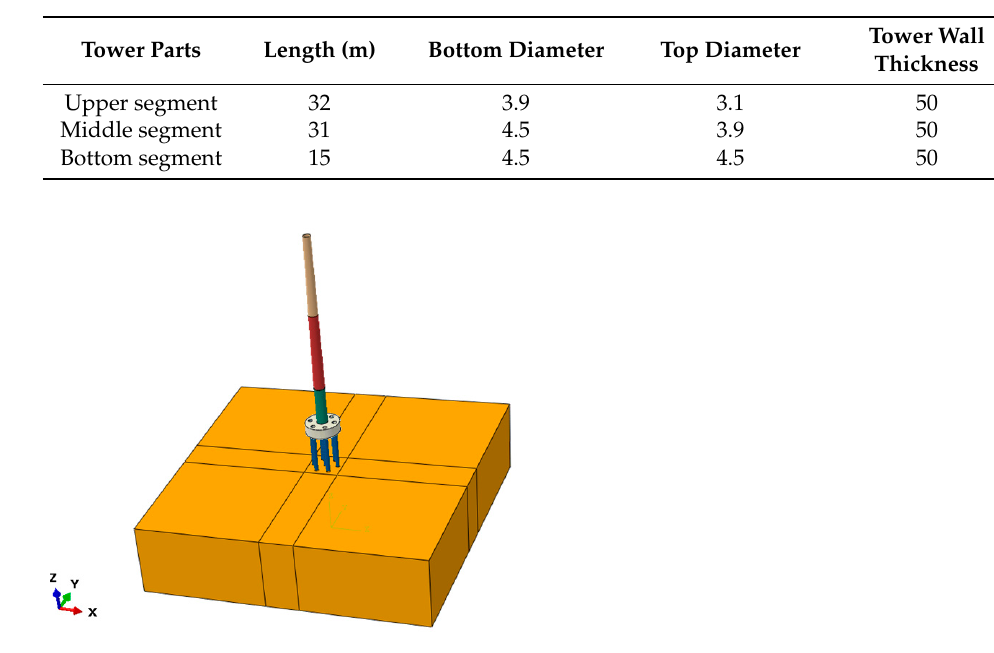
Figure 7. FEM numerical simulation model.